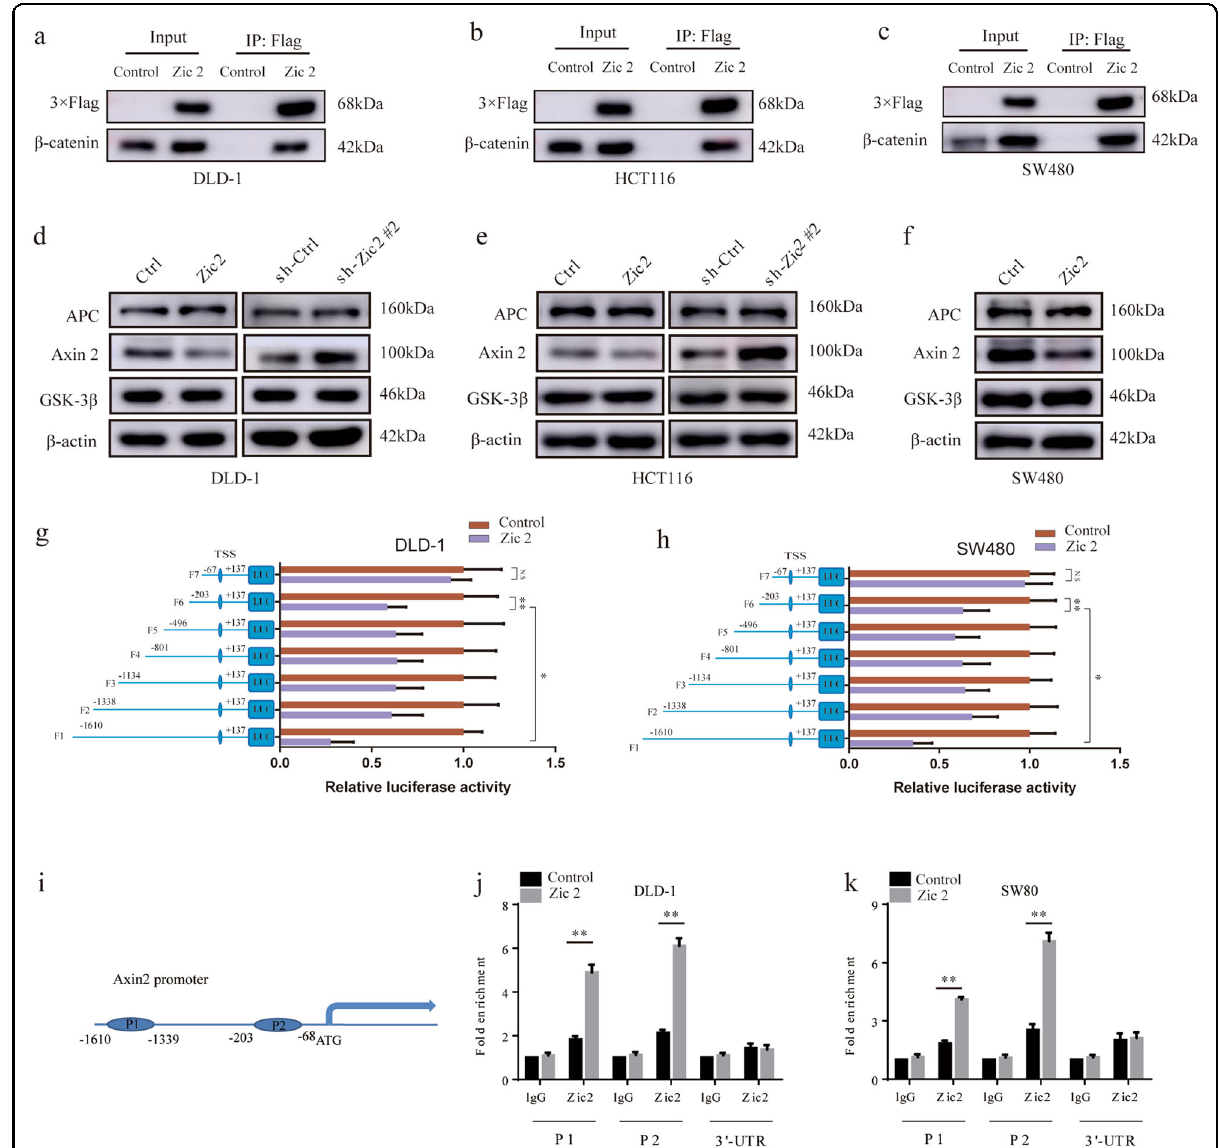
Fig. 5 Zic2 activates Wnt signaling in colon cancer cells by interaction with β -catenin and trans-repression of Axin2. a – c Validation of β -catenin co-immunoprecipitation with Zic2 by western blot. d – f The protein levels of APC, Axin2, and GSK-3 β were detected in silenced Zic2- silencing and Zic2-overexpressing cell lines by west blotting. g , h Fragments of the Axin2 promoter were constructed to generate promoter reporter. The luciferase activity relative to Renilla control was measured in Zic2-overexpressing DLD-1 or SW480 cells and their scramble infectants. i A schematic diagram of the two binding regions of Axin2 promoter by Zic2. j , k The qChIP assay was shown in Zic2-overexpressing DLD-1 or SW480 cells and heir scramble infectants and Immunoprecipitation by Zic2 antibody and IgG antibody. All data are presented as the mean ± SD from three independent experiments. * P < 0.05, ** P <